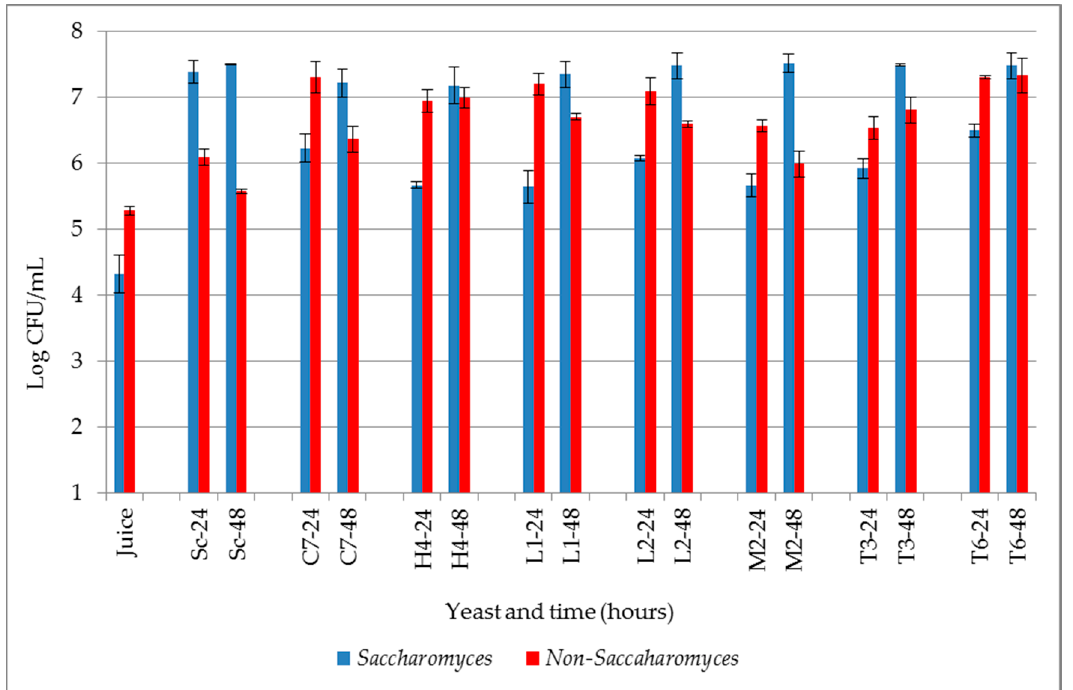
Figure 1. Saccharomyces and non- Saccharomyces yeast counts in colony forming units/millilitres (CFU/mL) of Shiraz juice, wines inoculated with a commercial Saccharomyces cerevisiae (Sc) strain on its own and wines with S. cerevisiae in combination with Candida zemplinina C7, Hanseniaspora uvarum H4, Lachancea thermotolerans strains L1 and L2, Metschnikowia pulcherrima M2 and Torulaspora delbrueckii strains T3 and T6 were evaluated. The yeast counts were performed after 24 and 48 h of the alcoholic fermentation. Values are averages of three replicates and the error bars indicate the standard deviation.